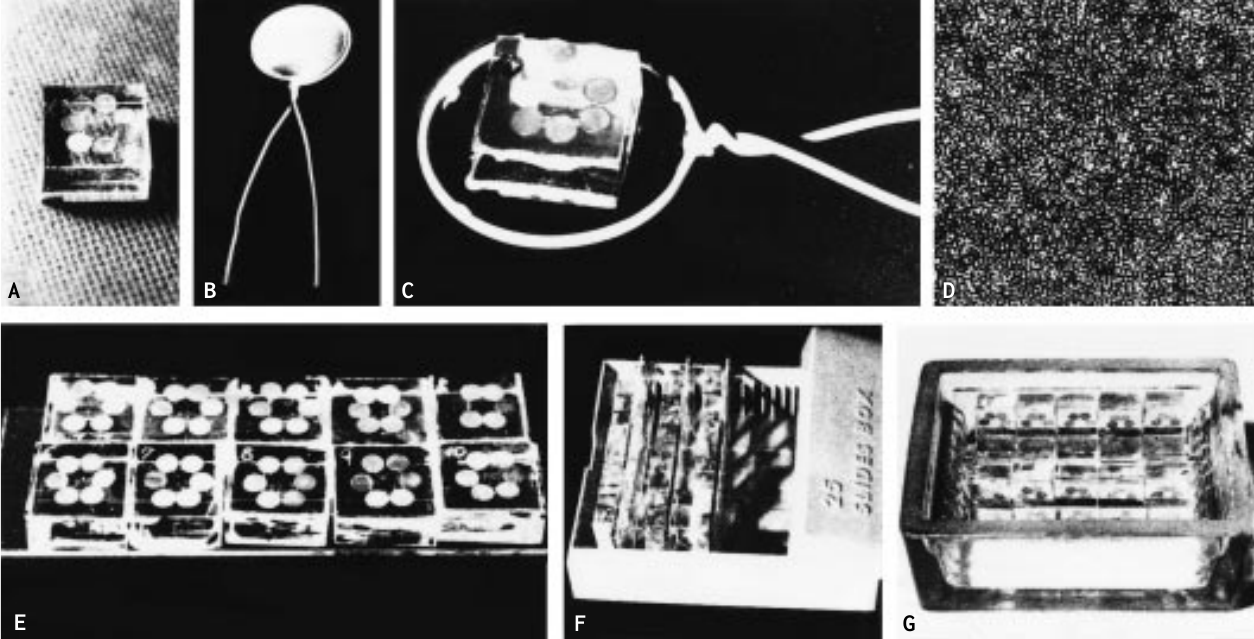
Figure 5 - Photographs showing the standard procedure for preparing EMRAG by the wire-loop method. A, Six meshes carrying sections are placed on a square glass block. B, A large wire loop is dipped into the melted emulsion and a thin film of emulsion is obtained. C, The emulsion film with the wire loop is applied horizontally to a glass block on which 6 meshes are placed. D, The emulsion film is checked by transmission electron microscopy before development. Note the monolayer arrangement of silver bromide crystals in Konica NR-H2 emulsion. X6,000. E, Ten glass blocks carrying 6 meshes each are attached to a glass slide with Scotch tape. F, Several glass slides, each carrying 10 glass blocks, are stored in a slide box for exposure. G, All the meshes on glass blocks are developed, fixed and stained